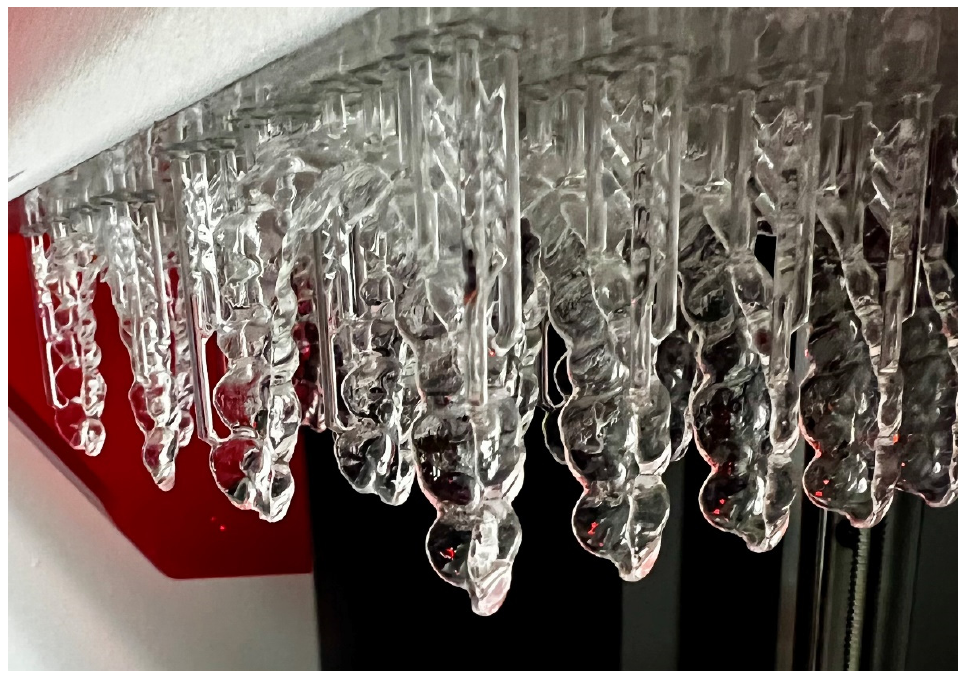
Figure 8. Direct ‐ printed aligners